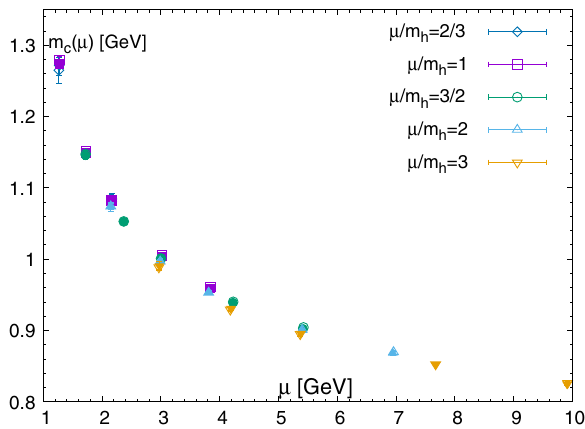
Fig. 3 The running charm-quark mass. The filled symbols correspond to the determination from R 6 , while the open symbols correspond to the determination from R 8 . The different symbols refer to different choices of μ for a given value of m h